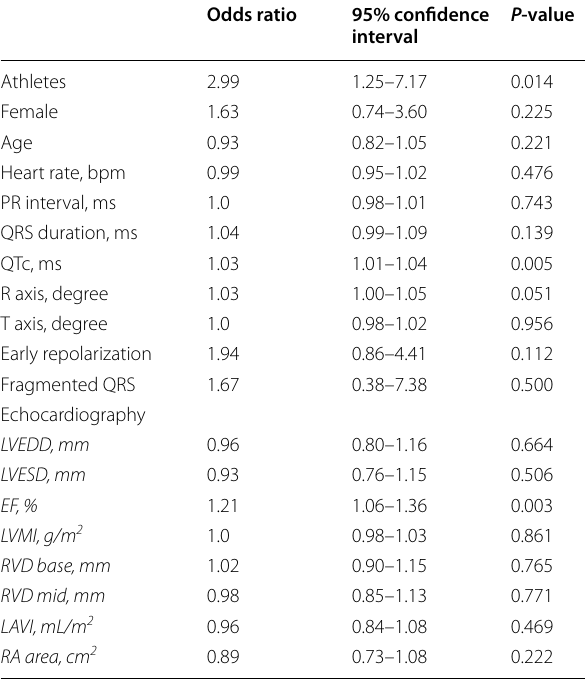
Table 3 Binary logistic regression analysis of factors associated with the presence of ventricular late